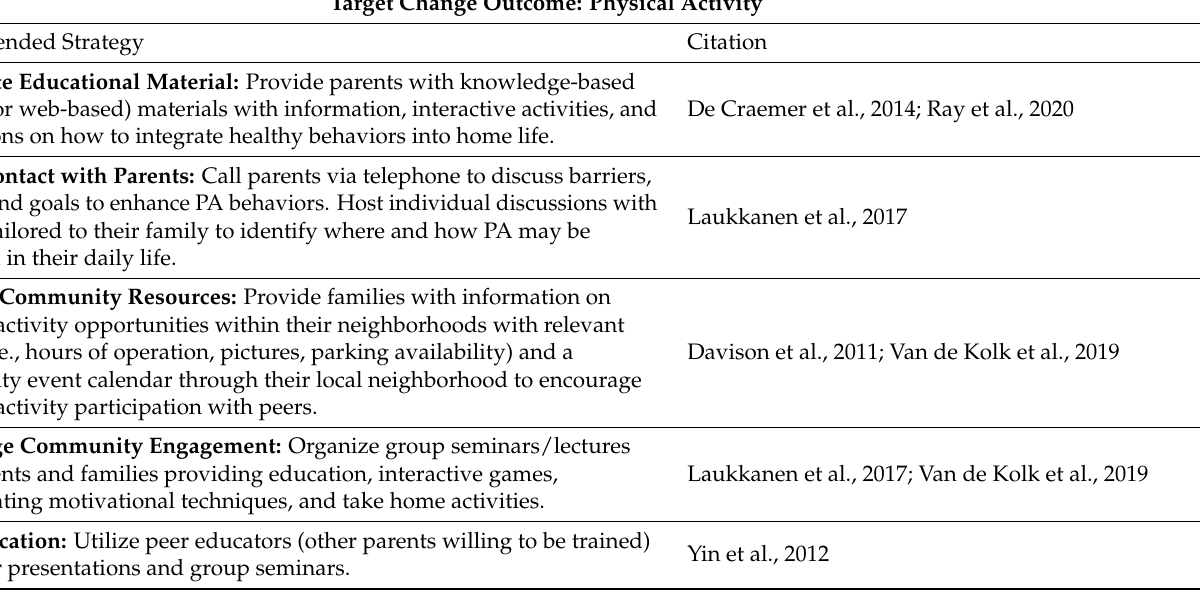
Table 5. Recommended home- and community-based strategies for early childhood physical activity promotion.